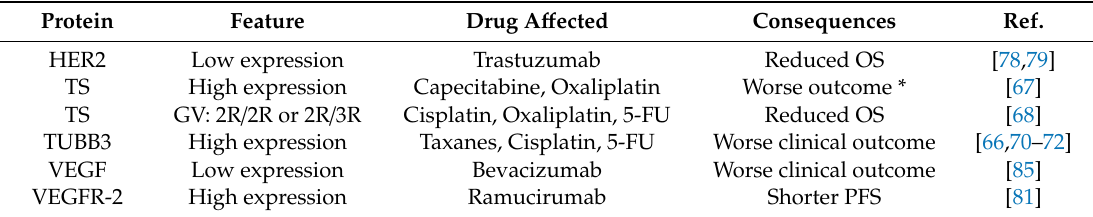
Table 3. Mechanisms of chemoresistance type 3 (MOC-3) to drugs used in the treatment of GAC. Protein Feature Drug A ff ected Consequences Ref. HER2 Low expression Trastuzumab Reduced OS [78,79] TS High expression Capecitabine, Oxaliplatin Worse outcome * [67] TS GV: 2R / 2R or 2R / 3R Cisplatin, Oxaliplatin, 5-FU Reduced OS [68] TUBB3 High expression Taxanes, Cisplatin, 5-FU Worse clinical outcome [66,70–72] VEGF Low expression Bevacizumab Worse clinical outcome [85] VEGFR-2 High expression Ramucirumab Shorter